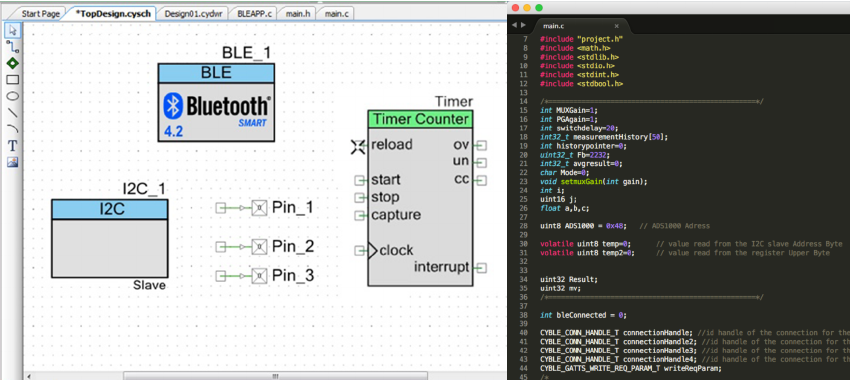
Figure 6. Screenshot from PSoC Creator IDE software showing the final BLE application schematic and a part of the main